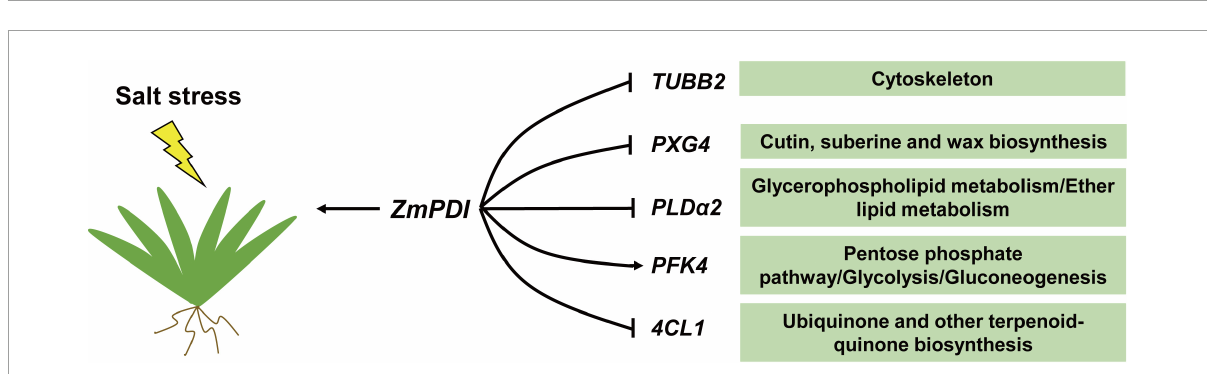
FIGURE5 A predictive regulatory model of ZmPDI enhancing salt tolerance in Z. matrella . The contents in the green boxes are the GO term or KEGG pathways of the genes on the left belong.